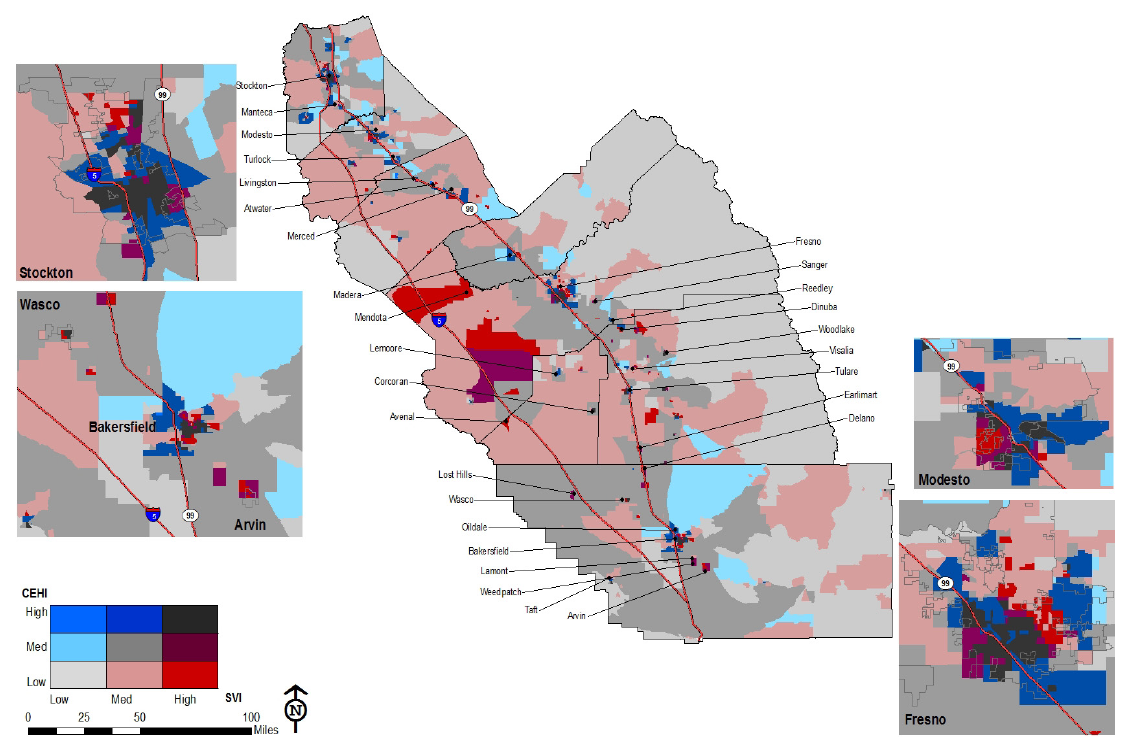
Figure 3. CEVA for the San Joaquin